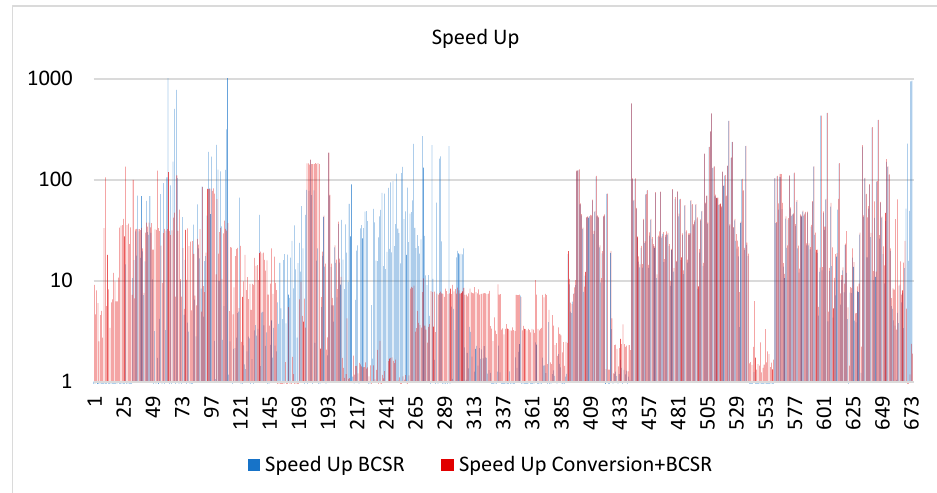
Figure 10. Speedup of BCSR (with and without format conversion time) against CSR.